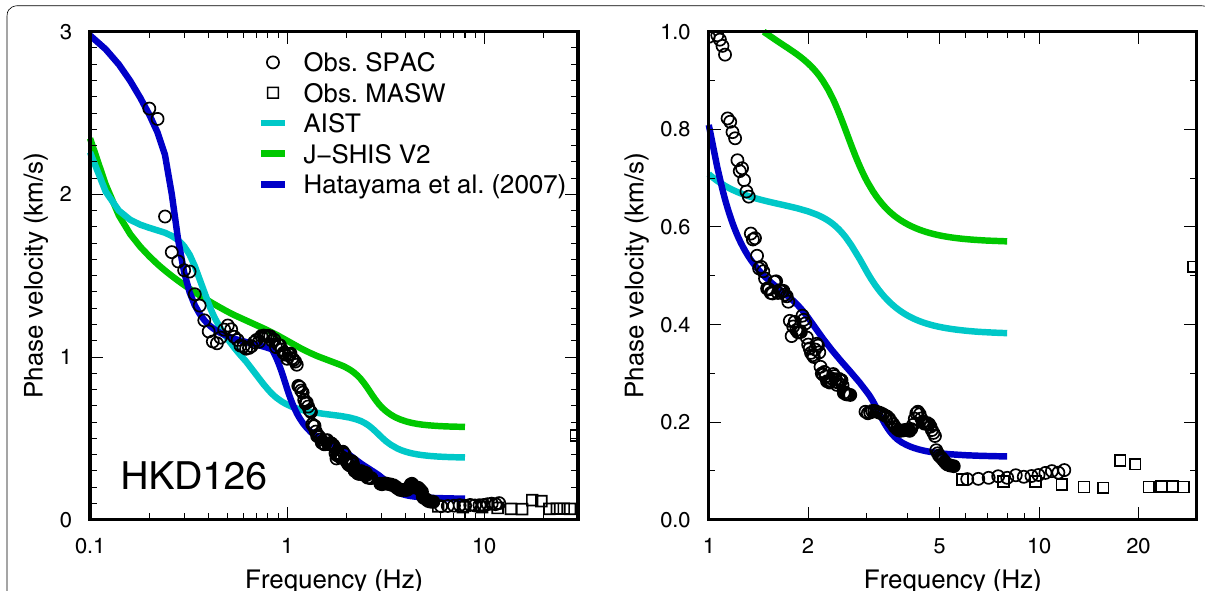
Fig. 8 Phase velocities of Rayleigh waves at HKD126. The open circles denote the observed phase velocities using the SPAC method and the open squares denote those obtained using the MASW method. The solid lines denote the theoretical phase velocities for the AIST, J-SHIS V2 and Hatayama et al. (2007) models. The right panel shows the details of the low velocity part